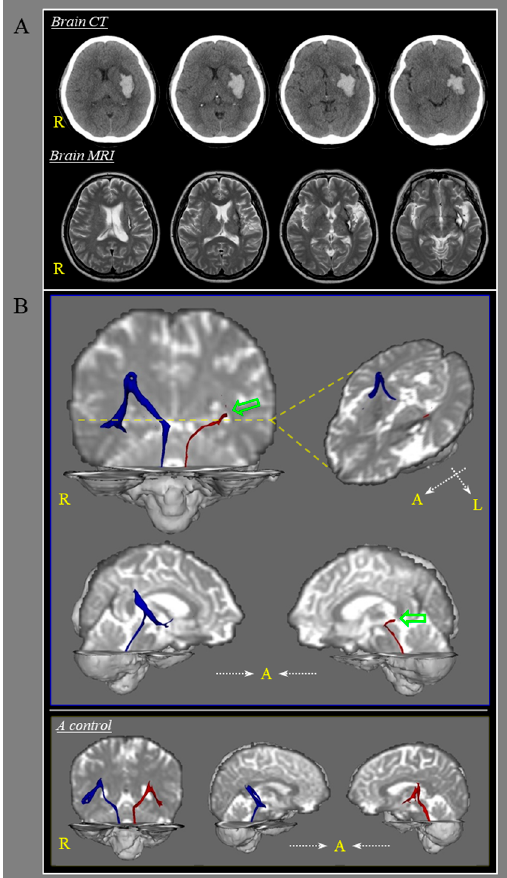
Figure 1. A 51-year-old female patient underwent conservative management for a spontaneous intracerebral hemorrhage (ICH) in the left basal ganglia (mainly a ff ecting the internal capsule and insular cortex) ( A ). When she visited the rehabilitation department of the university hospital at two years after the ICH onset, she reported that moderate dizziness (mainly, light-headedness) had started after the ICH onset. She mentioned that her dizziness had decreased slightly over time. Physical examination by an otorhinolaryngologist revealed no abnormalities in the vestibular system of either ear. She also exhibited mild right hemiparesis; however, her cognitive function was within the normal range (Mini-Mental State Examination score, 28, cuto ff value: < 25). Brain magnetic resonance images were obtained two years after onset and revealed leukomalactic lesions in the left basal ganglia and the subcortical white matter of the insular cortex ( A ). On di ff usion tensor tractography, the patient’s core vestibular projection in the left hemisphere (red) showed discontinuation (green arrows) at the basal ganglia level compared with that of the patient’s right core vestibular projection (blue) and those of a normal subject ( B ). The patient and a normal subject (50-year-old female) provided written informed consent for participation in this study, and the study protocol was approved by the Yeungnam university hospital institutional review board (YUMC-2019-06-032, 28 June 2019). A: anterior, R: right, L: left, Yellow dotted line: level of